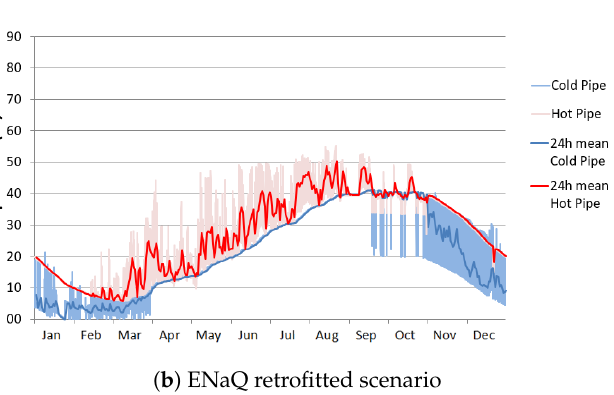
Figure 7. Hourly and daily district network temperature in